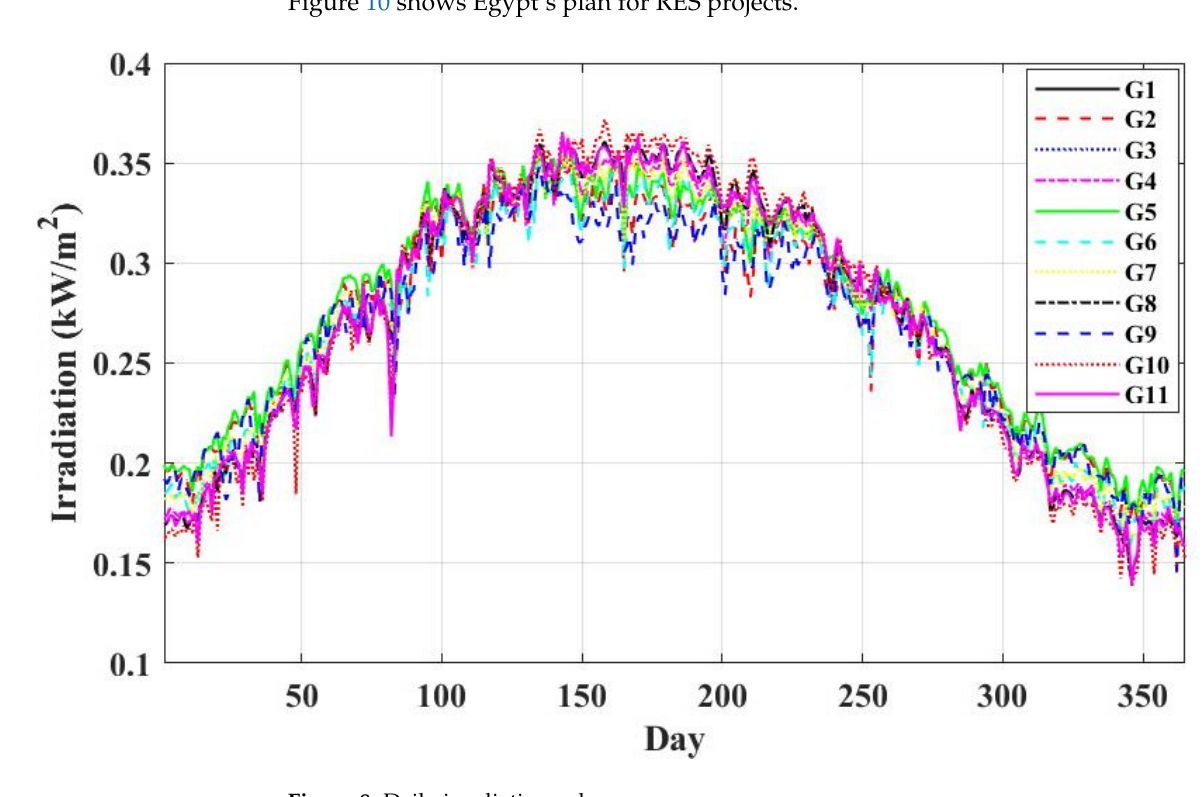
Figure 8. Daily irradiation value per year.